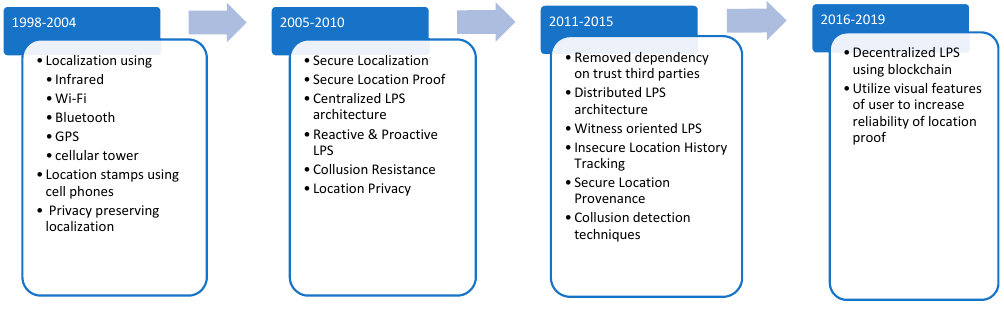
Figure 1. Evolution timeline of location proof systems.